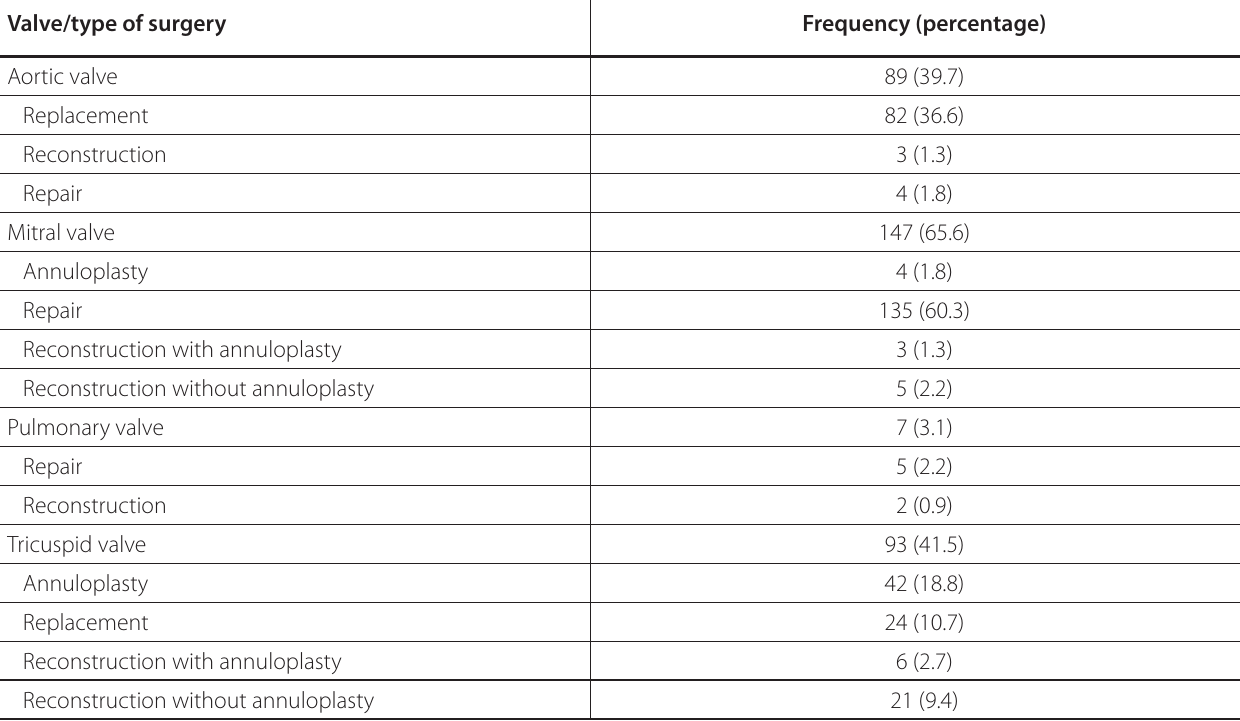
Table 1 . Frequency of the types of valvular surgery in the study population (n=224).